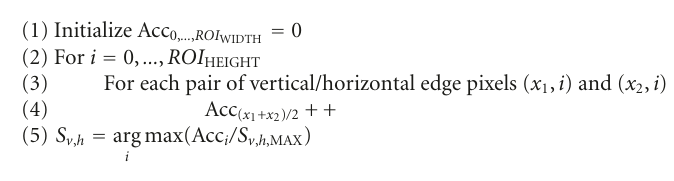
Algorithm 1: Vertical and horizontal edges symmetries computation